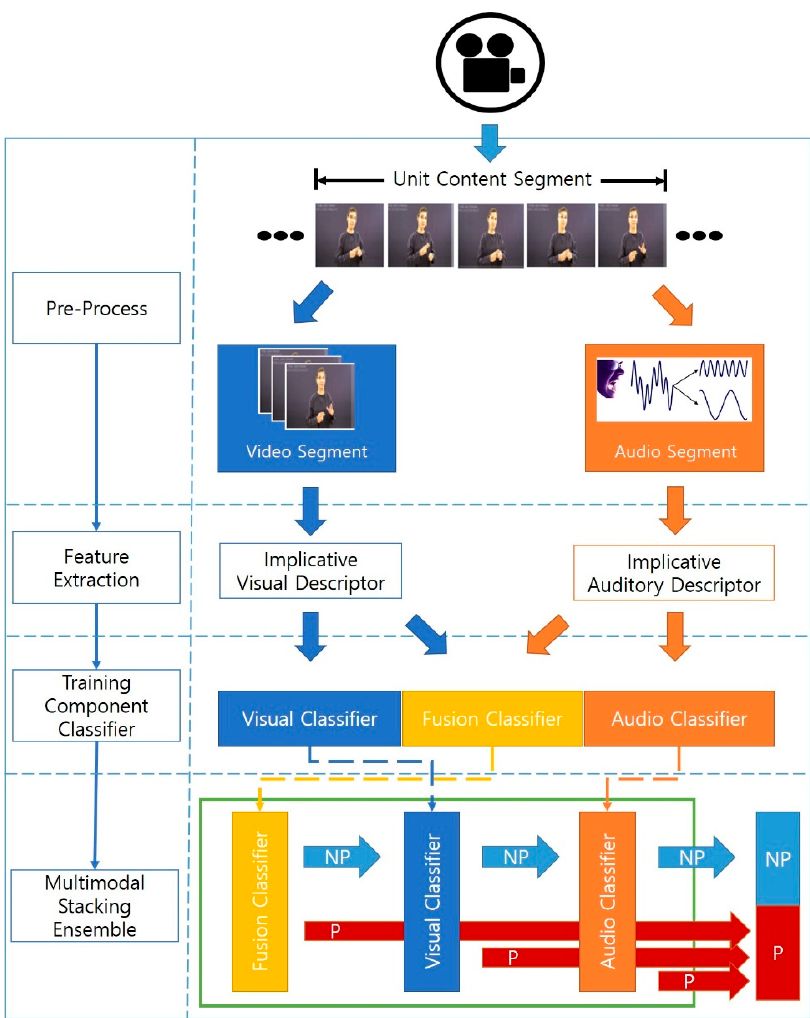
Figure 1. Overall procedure of the proposed multimodal stacking scheme.